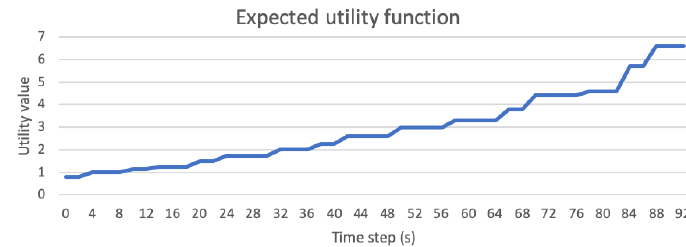
Figure 8. Utility function for a robot using a factored Markov Decision Processes (FMDP)